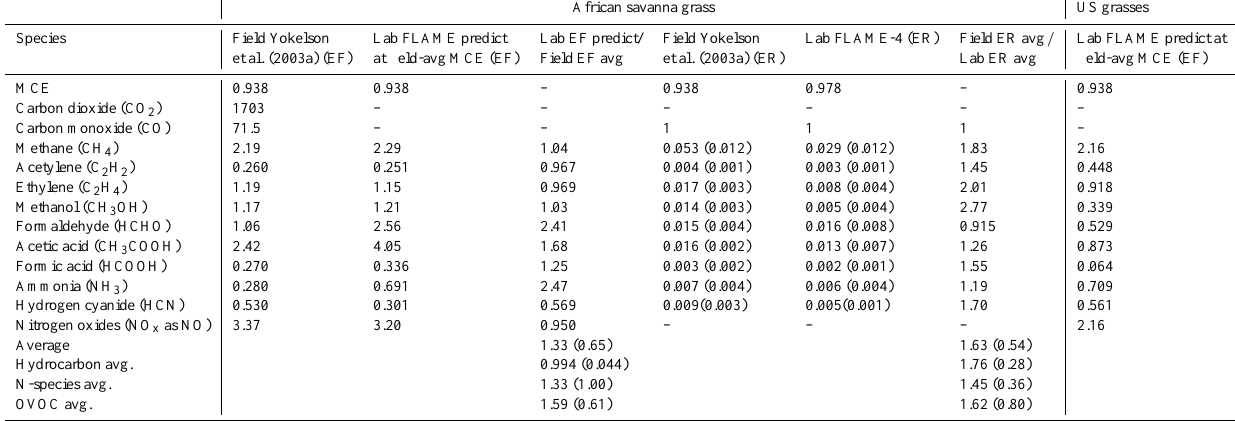
Table 2. Summary of the comparison of emission factors and emission ratios (to CO) measured in the lab and field for savanna fuels and projected emission factors for US grasses calculated at the savanna grass field-average MCE. Values in parentheses are one standard deviation.